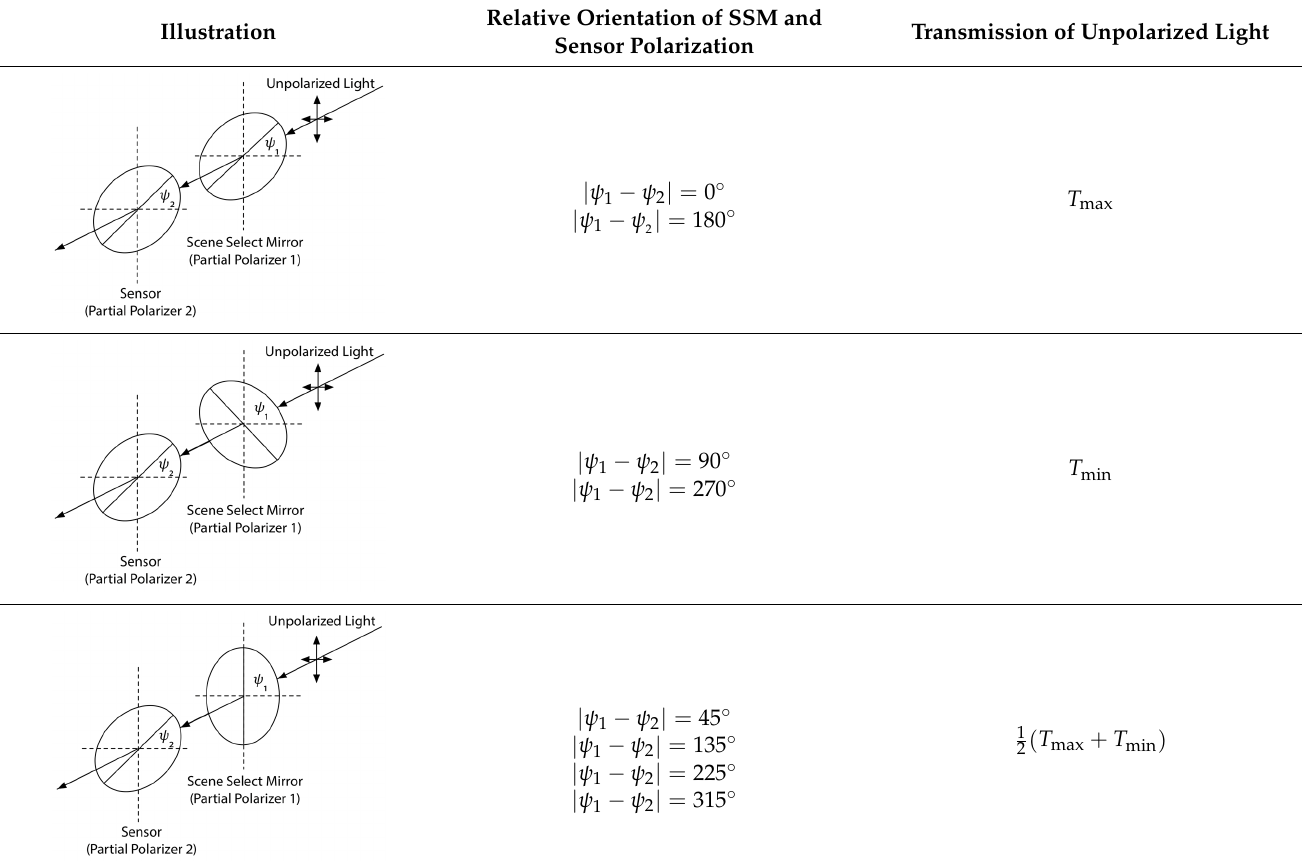
Table 1. Relative orientation of scene select mirror and sensor polarizations and resulting transmission for unpolarized light. Illustration